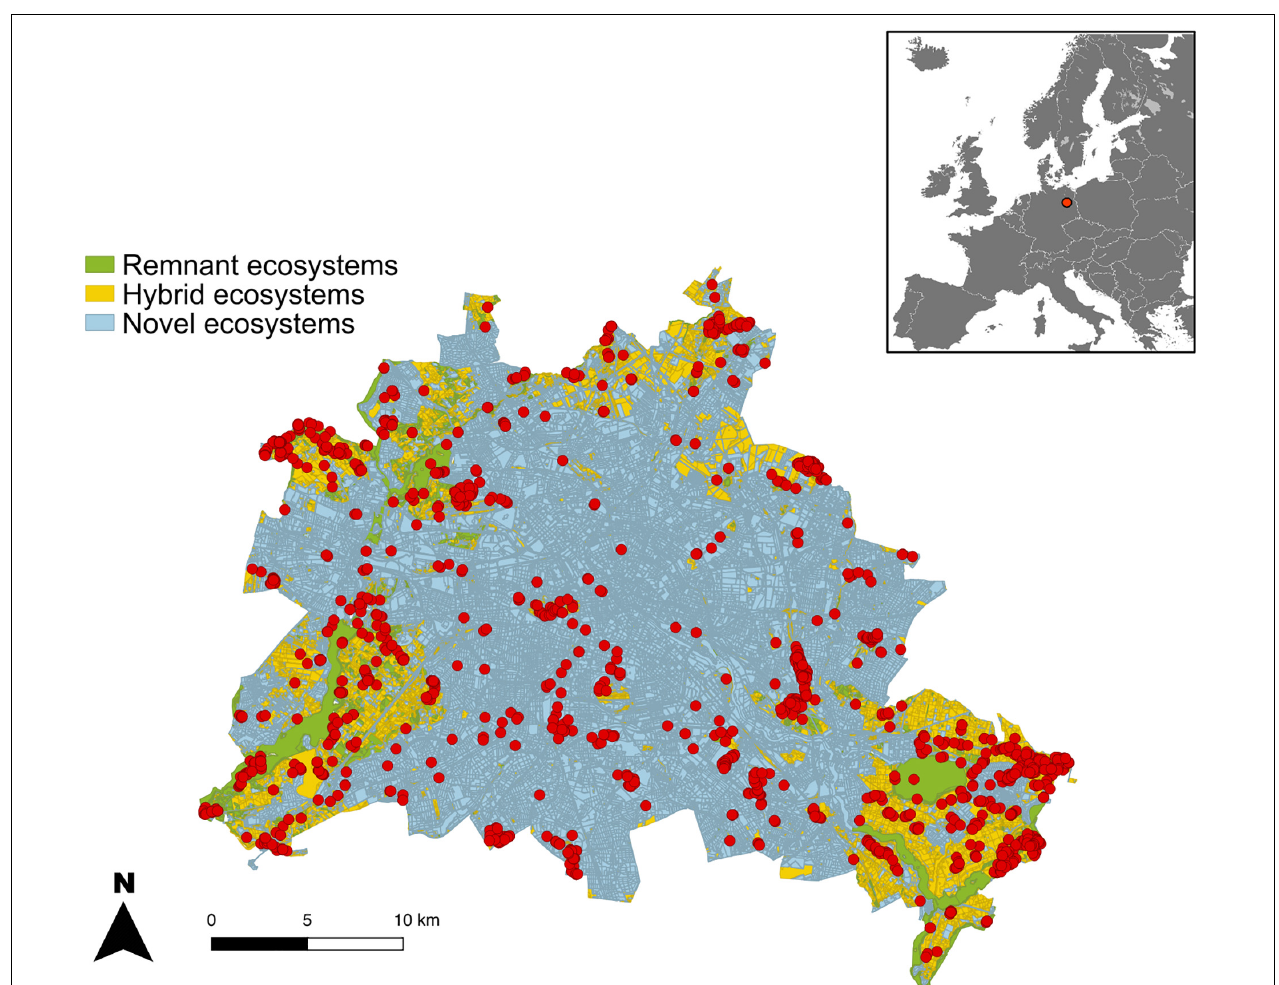
FIGURE 1 | Location of populations of endangered plant species (213 species, 1742 populations, red dots) across remnant, hybrid and novel ecosystems inside the city limits of Berlin. The configuration of the urban matrix is overlaid in darker